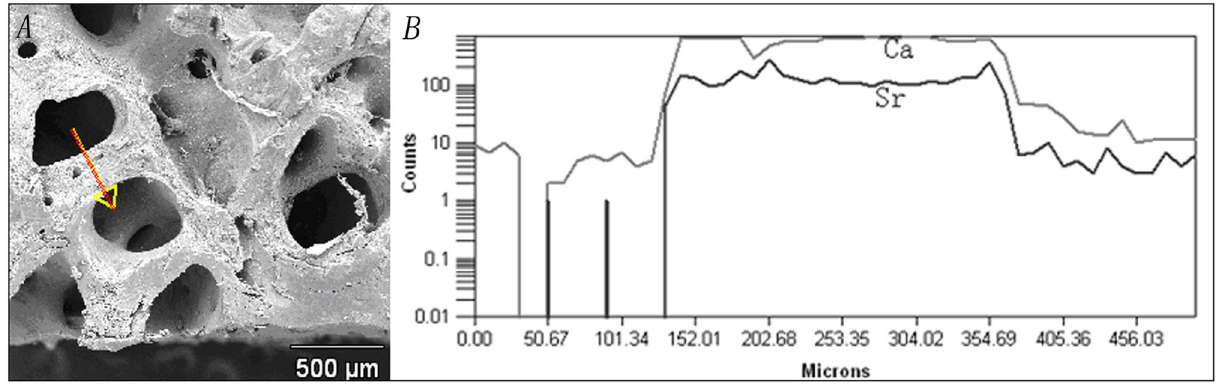
Figure 2. Line scanning route and distribution of Ca and Sr elements in ABS . A) The arrow shows the scanning route. B) The relative quantity of Ca and Sr elements across the scanning route. X axis represents the distance from the starting point and the Y axis represents the relative quantity of each element recorded during the examination.